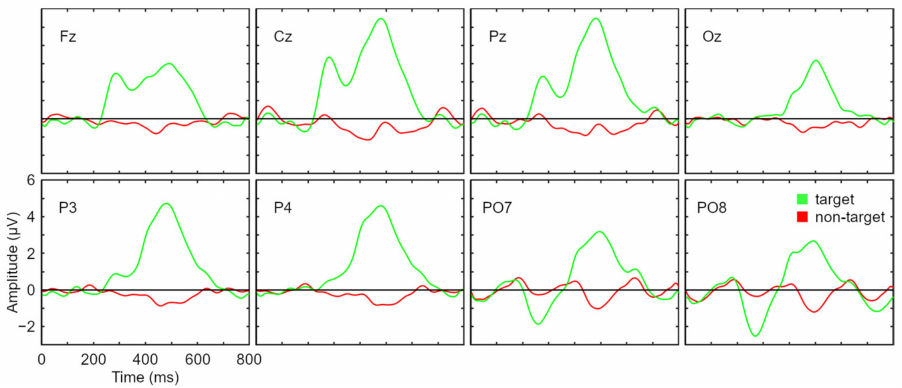
Figure 4. Grand average event-related potential waveforms ( µ V) for target and non-target stimuli in each electrode position. Table 3. Online task results in terms of number of sequences used (Seq), selections made (Selected commands), time to complete each task (Time required), and overall accuracy (Acc). The sub column Total in Selected commands shows two values: the first one is the sum of Task 1 to Task 4, the second value represents the minimum number of actions